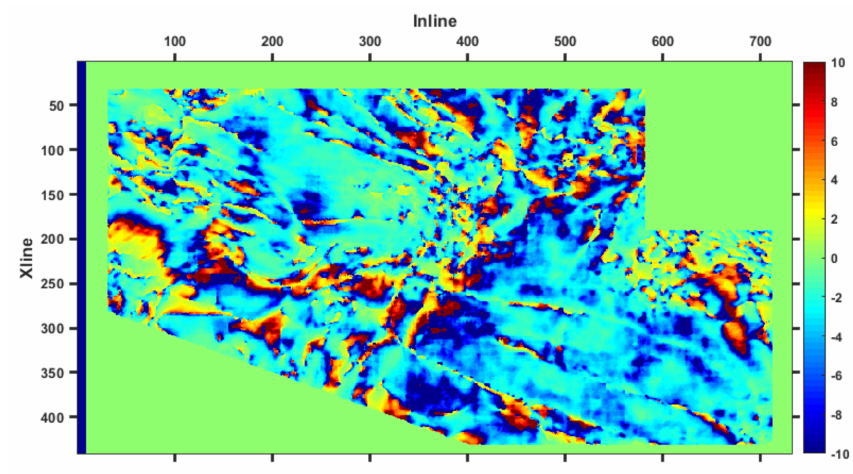
Figure 14. The attenuation coefficient attribute of the coal seam.